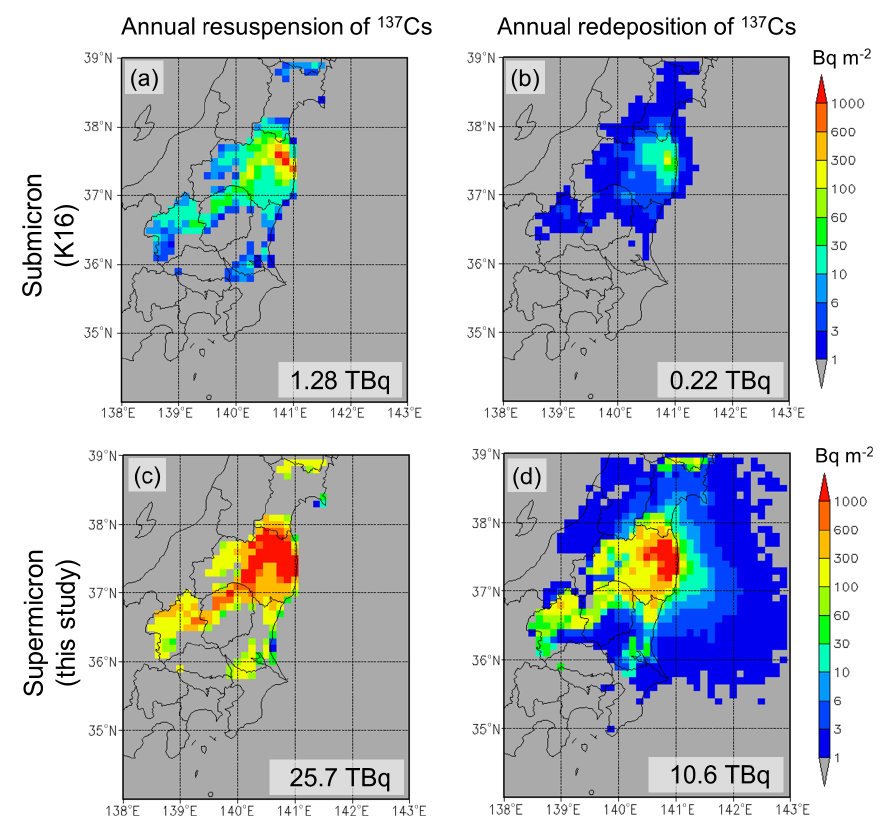
Figure 7. Horizontal distributions of (a, c) the annual total amounts of resuspended 137 Cs (Bqm − 2 ) and (b, d) redeposited amounts of re- suspended 137 Cs (Bqm − 2 ) obtained from the simulations assuming (a, b) submicron (K16; E c and v d are 0.04 and 0.1cms − 1 , respectively) and (c, d) supermicron (this study; E c and v d are 0.4 and 10cms − 1 , respectively) sizes of 137 Cs-bearing particles. The total areal amounts are embedded at the bottom right of each